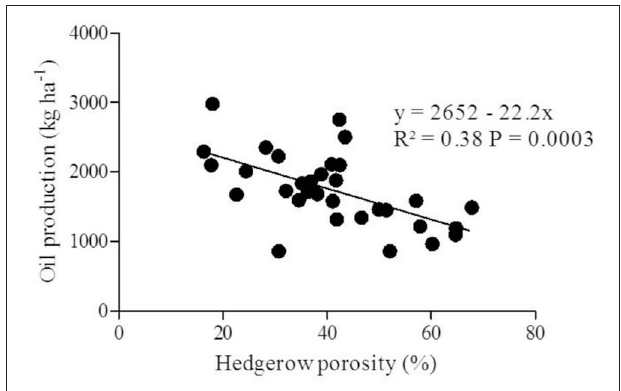
FIGURE 7 | Relationship between oil production (kg ha − 1 ) and hedgerow porosity (%) from the fourth until ninth after planting trees established at different intra-row spacing. Each point corresponds to two replicate trees per intra-row treatment in the various study